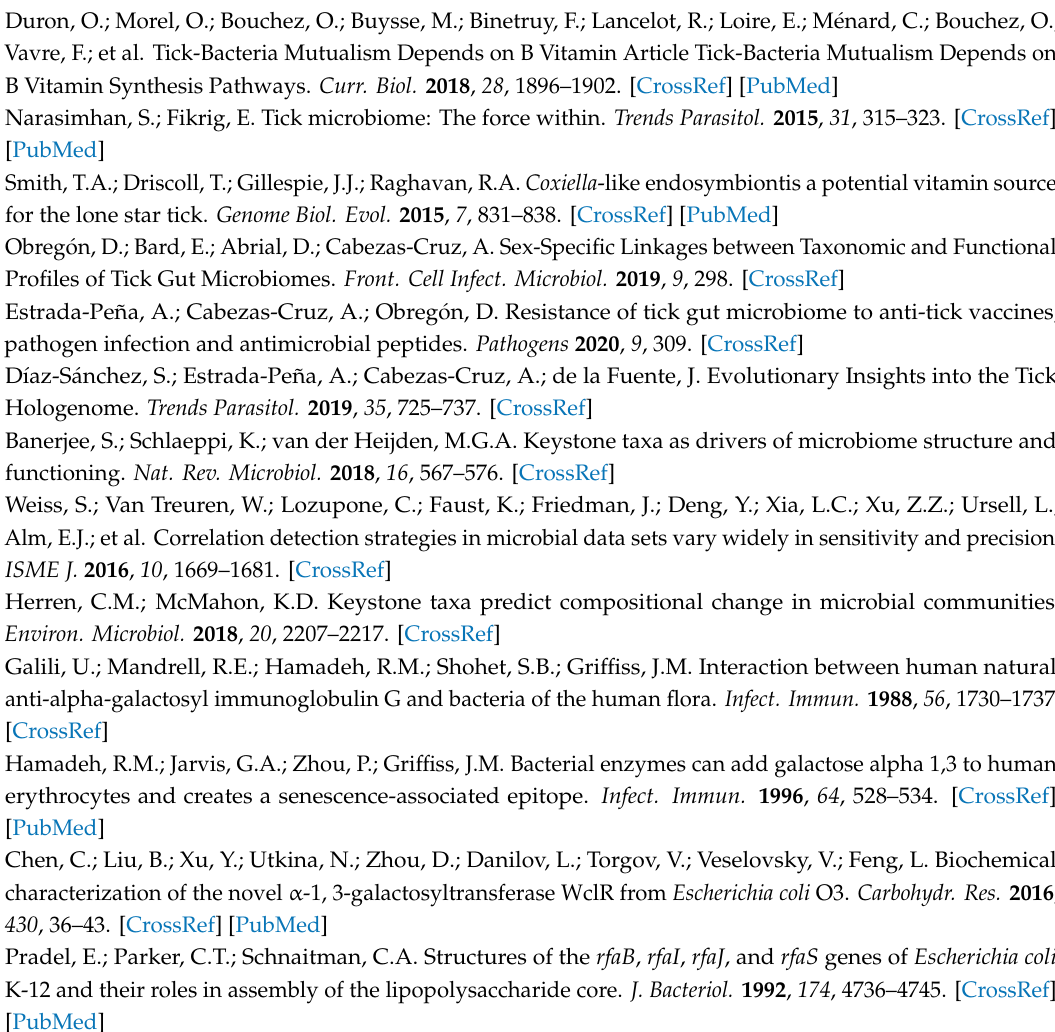
Table S1. Values of eigencentrality and relative abundance of bacteria taxa in I. scapularis and I. ricinus